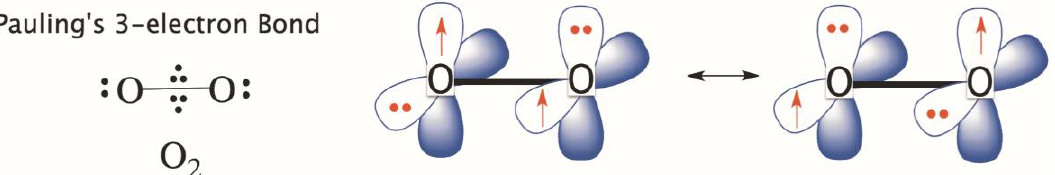
Scheme 3. The electronic structure of O 2 according to Pauling, involving two three-electron π bonds in two perpendicular planes. These are shown in the right drawings, using two resonance structures (1e, 2e 2e,1e) .